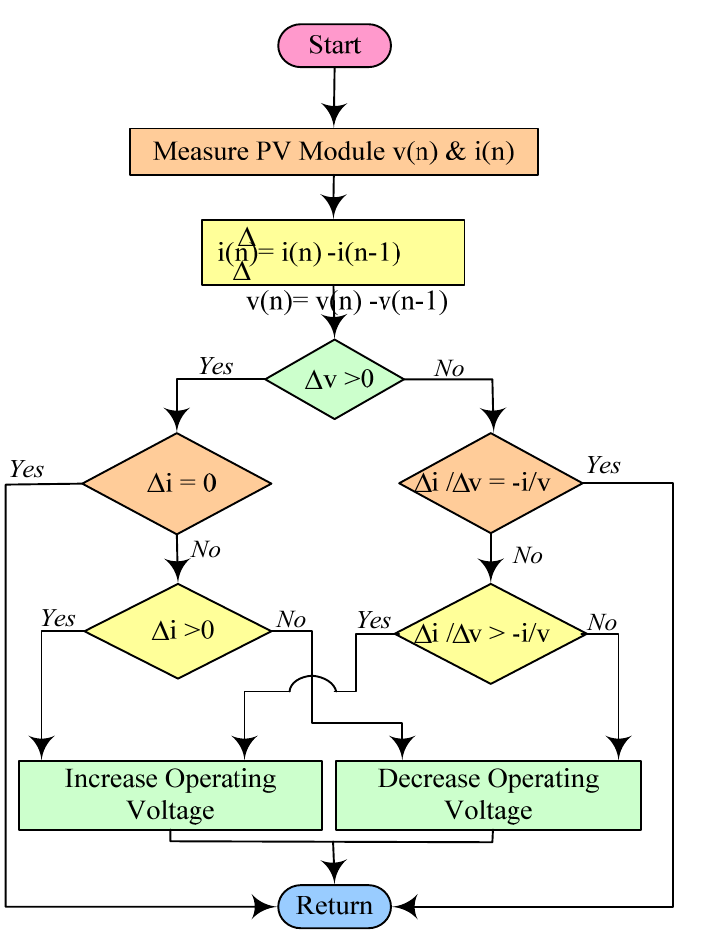
Figure 9. INC-based MPPT technique [27].